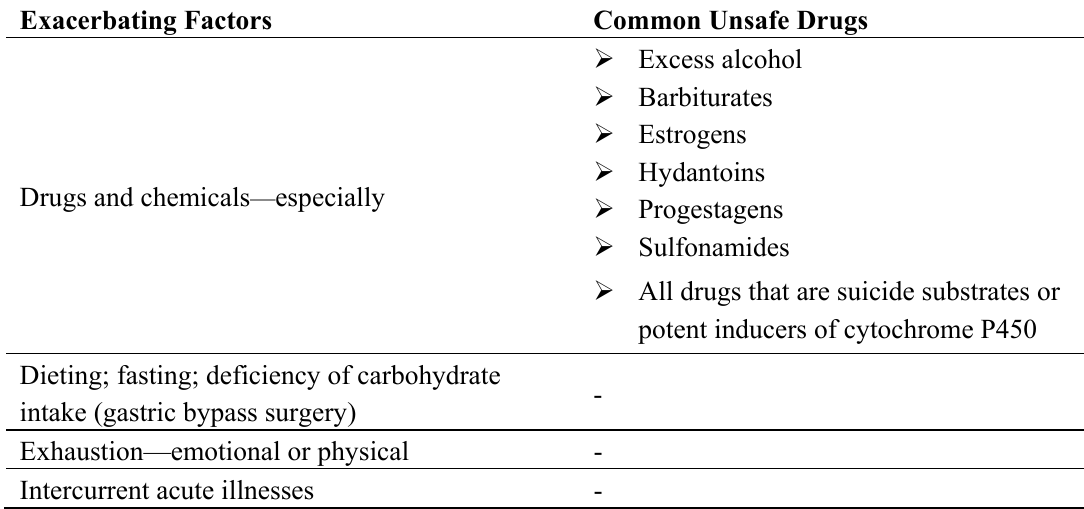
Table 3. Factors known to trigger or exacerbate acute attacks of porphyria